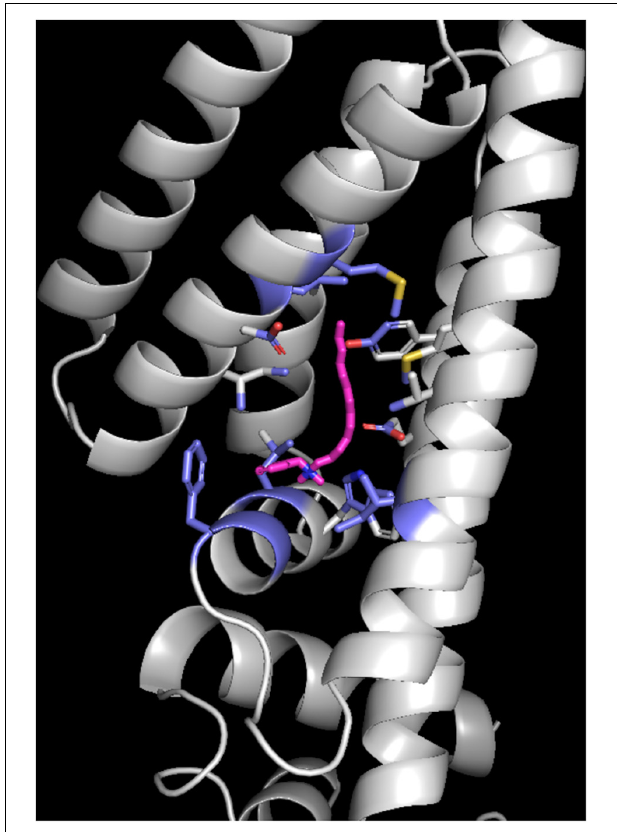
FIGURE 3 | Docking of benzalkonium chloride (pink) in the predicted pocket of FepR using the P2Rsankweb application. The predicted interacting residues are shown in violet. Oxygen atoms are shown in red, nitrogen in blue, sulfur in